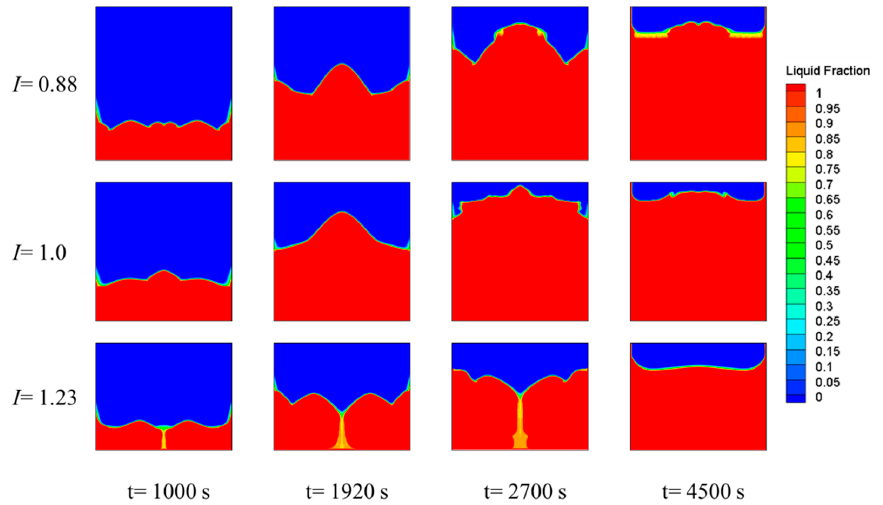
Figure 9. Phase fields for the melting process at different I